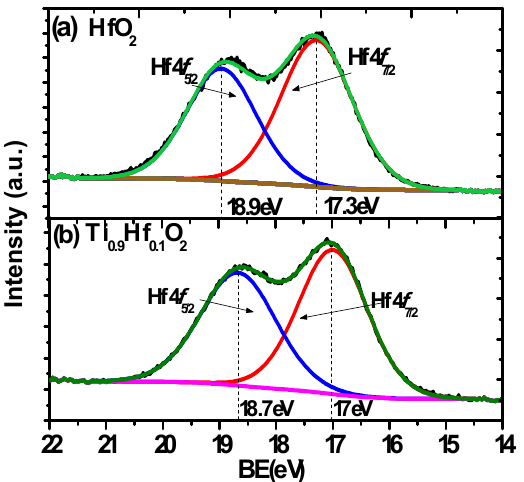
Figure 3. The Hf 4 f spectra from 5 nm thick films of ( a ) HfO 2 and ( b ) Ti 0.9 Hf 0.1 O 2 on Ge. The Hf 4 f 7/2 binding energy from Ti 0.9 Hf 0.1 O 2 is 17 eV with a smaller shift compared to the HfO 2 with a shift of 17.3 eV.